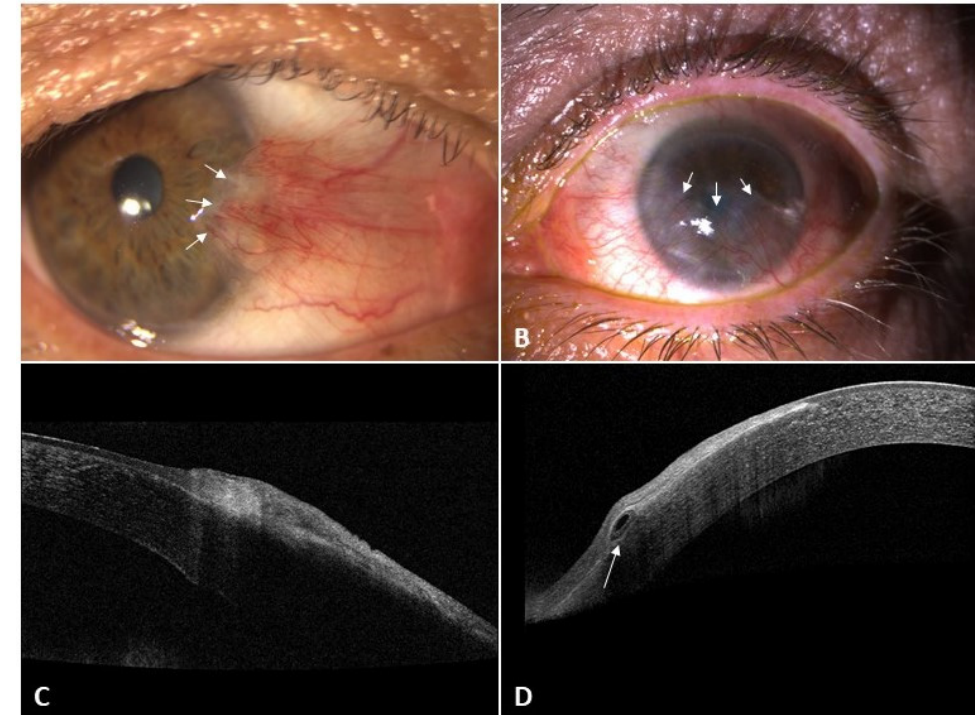
Figure 1. Differential features of pterygium and pseudopterygium in slit-lamp and AS-OCT examination DRI-OCT Triton Swept-Source OCT (Topcon, Tokyo, Japan). ( A ) Pterygium in slit-lamp (arrow); ( B ) pseudopterygium in slit-lamp (arrow); ( C ) pterygium in OCT (no plane of cleavage between the lesion and corneal epithelium); ( D ) pseudopterygium in AS-OCT in a horizontal scan. Notice (arrow) an overgrowing membrane that is not attached to the underlying cornea and there is a real plane of cleavage between it and the corneal epithelium. AS = Anterior segment. Anterior segment optical coherence tomography (AS-OCT) is a valuable and objec- tive method in the evaluation of conjunctivalized corneas [7]. The pterygium is sand- wiched between the corneal epithelium above and a wavy destroyed Bowman’s mem- brane below with a mild affection of superficial stroma. Spectral domain AS-OCT images of pterygium show a wedge-shaped mass that causes an elevation of the corneal epithe- lium and its separation from Bowman’s layer. Immediately central to the cap of the pter- ygium the following structures appeared to be normal: the epithelium, Bowman’s mem- brane, and corneal stroma. On the other hand, in some cases of recurrent pterygium, wedge-shaped masses of tissue were found between the corneal epithelium and the un- derlying partly destroyed Bowman’s membrane. The central tip of these wedges was